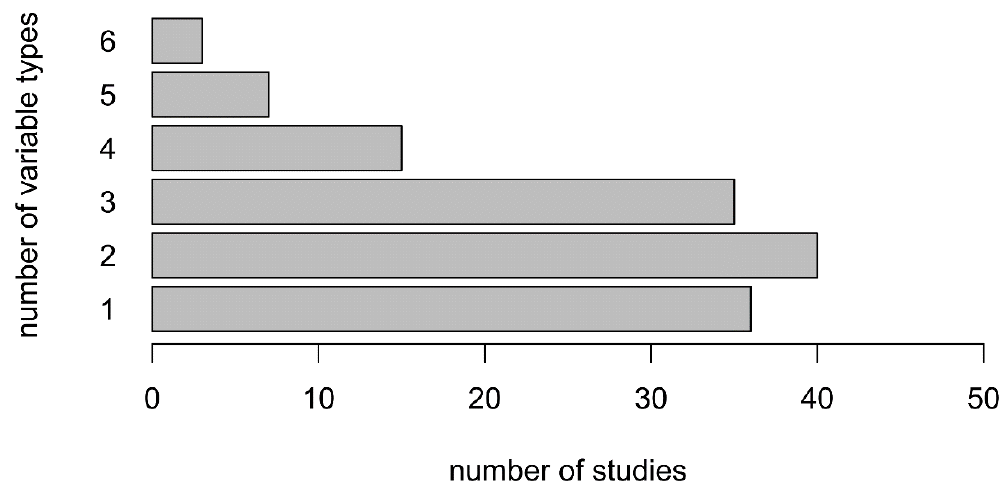
Figure 3. Number of studies reviewed by number of variable types used for classification of natural vegetation.